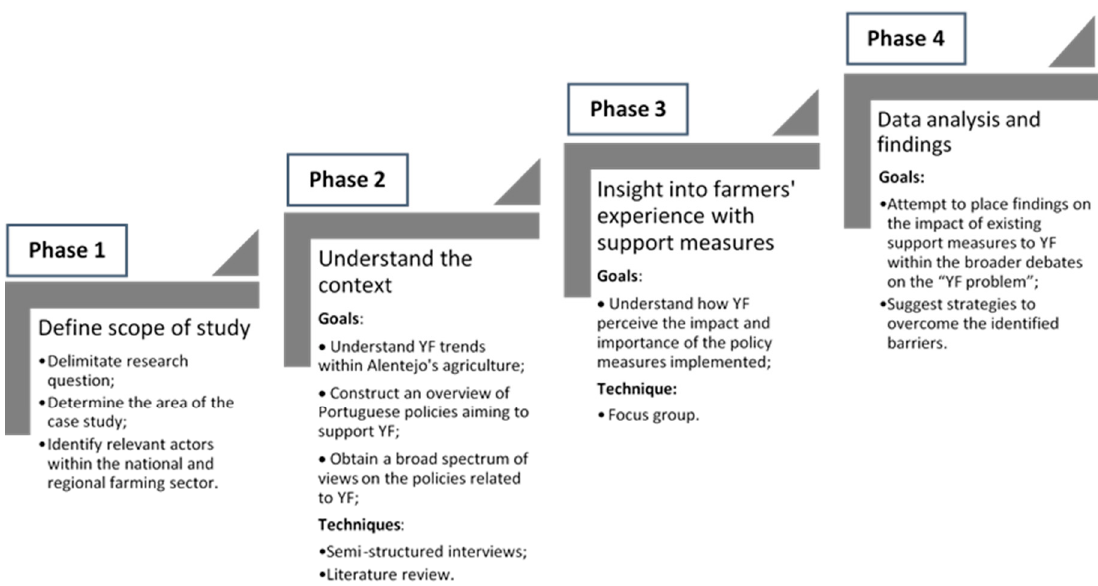
Figure 2. The methodological steps of our analysis.